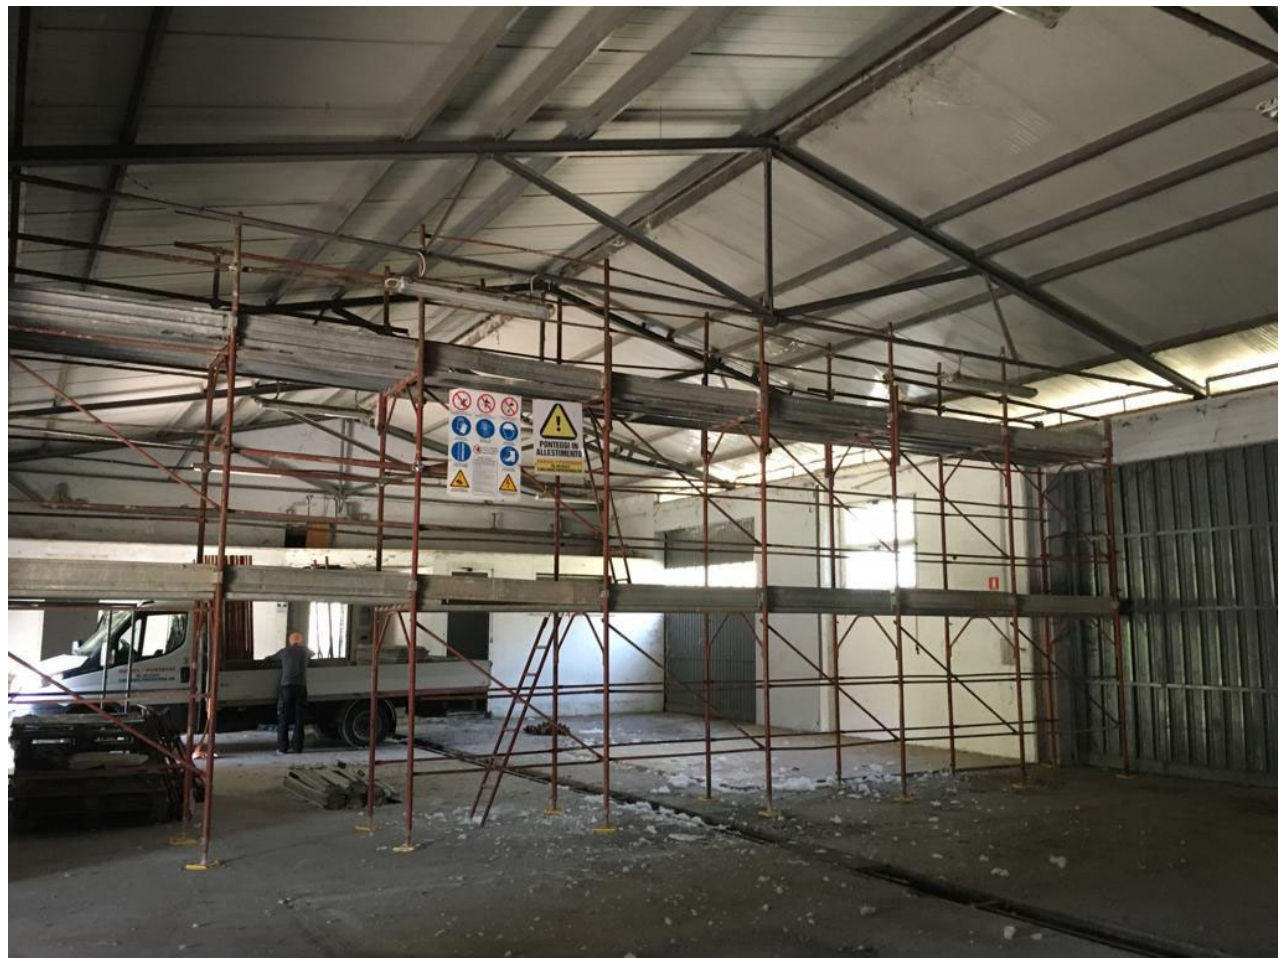
Figure 5. The church of Lunghezza during construction works. The iconostasis has three sets of doors (called ‘holy doors’ or ‘royal doors’) in the center, exclusively used by the clergy, and two side doors (called ‘deacon’s doors’), also used by those who help the clergy inside the altar (except women, who are not allowed to enter into the altar in the Orthodox tradition). On the opposite sides of the holy door are the icons of Christ and the Virgin Mary; toward the ends of the iconostasis, next to the deacon’s doors, are placed two wood aedicula, used to carry the icon of St. John the Faster (on the north) and the icon of the Virgin Mary (on the south), respectively. At the top of the iconostasis are icons of the apostles. It should be outlined that the architecture of the Orthodox places of worship carefully distinguishes the three areas of the space within the church (i.e., narthex, nave, and altar) and implies a specific orientation: churches are built to face east, and all religious rites are oriented toward the sanctuary (Gschwandtner 2019, p. 60). All spaces and objects within are arranged to create a specific ‘reality’ in between the material and the